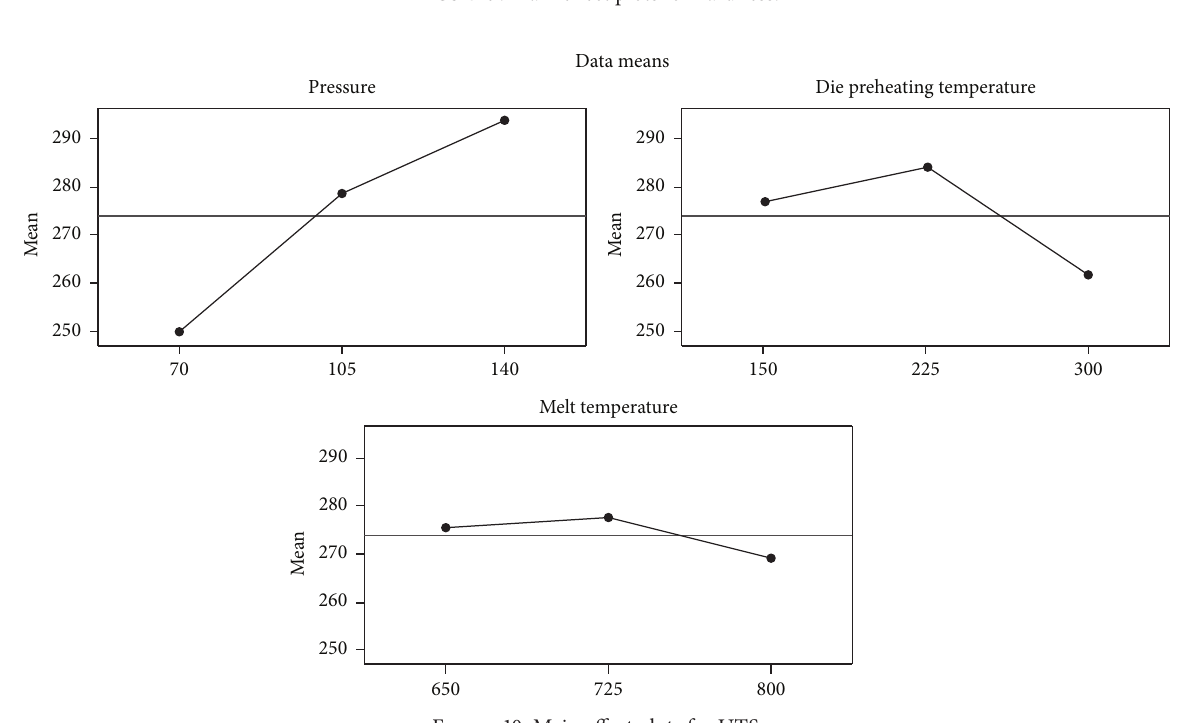
Figure 9: Main effect plots for hardness.